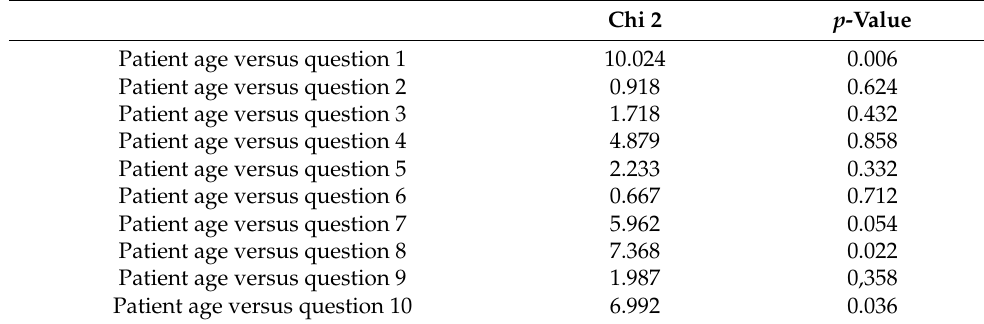
Table 4. The results of Questionnaire I according to the age of the subjects.